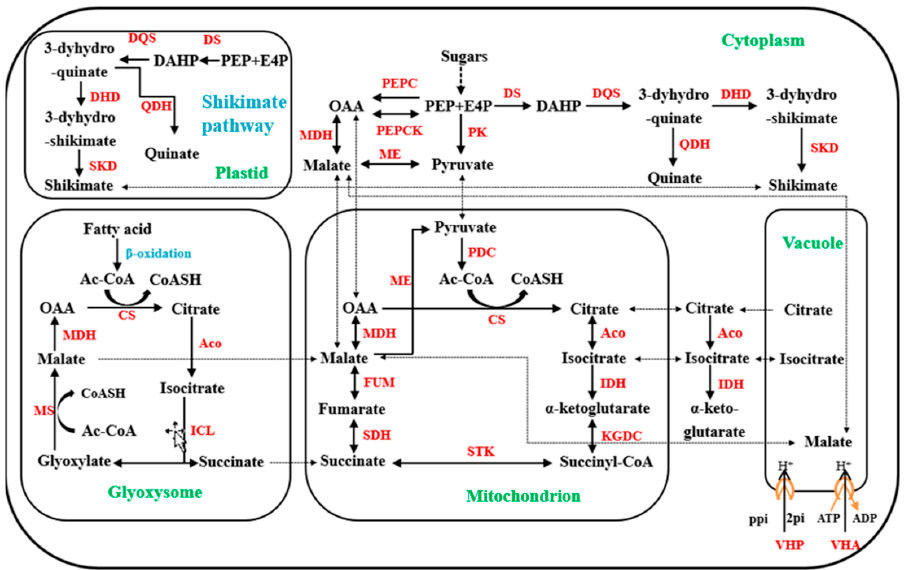
Figure 1. The current known metabolic pathways for organic acids in fleshy fruits. Abbreviations: acetyl coenzyme A, Ac-CoA; aconitase, ACO; coenzyme A, CoSAH; citrate synthase, CS; 3-deoxy-D- arabino-heptulosonate 7-phosphate, DAHP; dehydroquinate dehydratase, DHD; 3-dehydroqui- nate synthase, DQS; DAHP synthase, DS; erythrose-4-phosphate, E4P; fumarase, FUM; isocitrate lyase, ICL; isocitrate dehydrogenase, IDH; α - ketoglutaric acid dehydrogenase complex, KGDC; malate dehydrogenase, MDH; malic enzyme, ME; malate synthase, MS; oxaloacetic acid, OAA; py- ruvate dehydrogenation complex, PDC; phosphoenolpyruvate, PEP; PEP carboxylase, PEPC; PEP carboxykinase, PEPCK; pyruvate kinase, PK; quinate dehydrogenase, QDH; succinate dehydrogen- ase, SDH; shikimate dehydrogenase, SKD; succinate thiokinase, STK; vacuolar-type H + -ATPase, VHA; vacuolar-type H + -Ppase, VHP. Dashed arrows indicate organic acid transport. 2. Materials and Methods 2.1. Plant Materials and Sampling This study was conducted using five-year-old (in 2021) bearing loquat trees in fields of the loquat experimental station of College of Horticulture, Sichuan Agricultural Uni- versity, located at Shimian County, Ya’an City, Sichuan Province, China (29°18’ N, 102°32’ E). The trees were grafted on DWX rootstock with 4 m spacing between rows and 4 m between plants. The row orientation was from north to south. All plants were subjected to identical cultural practices for loquat in this area throughout the experiment, including normal irrigation, fertilization, pest control, and fruit-thinning. Four representative stages of loquat fruit development and ripening are the fruitlet (including a lag phase), cell expansion, breaker, and ripening stages according to [19] and our previous observations. CH loquat blooms in spring, so there is no lag phase in young fruit. Specifically, nine sampling points of DWX loquat included 40, 60, 80, 100, 120, 135, 150, 160, and 165 days after full bloom (DAFB), and eight sampling points of CH loquat were 30, 50, 60, 70, 80, 87, 94, and 101 DAFB, as shown in Figure 2A. The time when the whole inflorescence had approximately 75% of the flowers open at full-bloom stage was set as the baseline (0 DAFB). Loquat fruits grow rapidly approximately one and half months before harvest and were thus sampled at a shorter-time interval. Three fruit sam- ples were randomly collected from the upper, middle, and lower canopy of each tree. The fruit samples from five trees (in total fifteen fruits) consisted of one biological replicate. Each stage consisted of three biological replicates.